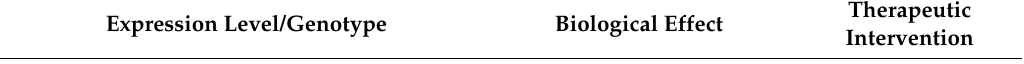
Table 2. CHRFAM7A involvement in neurological and non-neurological disorders. ↓ Reduced expression; ↑ increased expression; =, unchanged; n.d., not determined; und, undetectable. AD, Alzheimer’s disease; DLB, Dementia with Lewy’s bodies; PiD, Pick’s disease; PD, Parkinson’s disease; HAND, HIV-1-associated neurocognitive disorder; HSC, hematopoietic stem cell; NSCLC, non-small cell lung carcinoma. Numbers in square brackets indicate